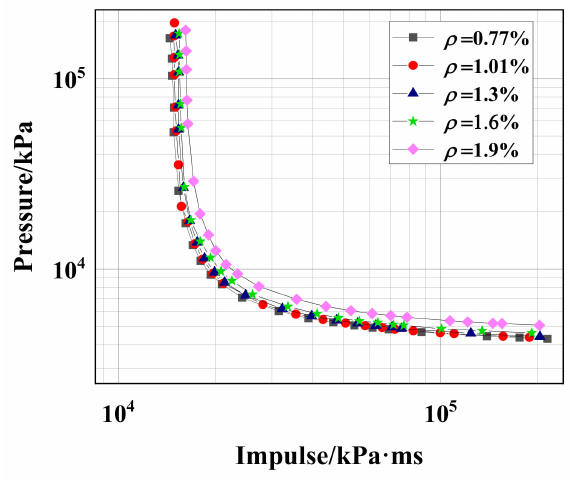
Figure 21. P-I curves of bending response with different longitudinal reinforcement ratios.